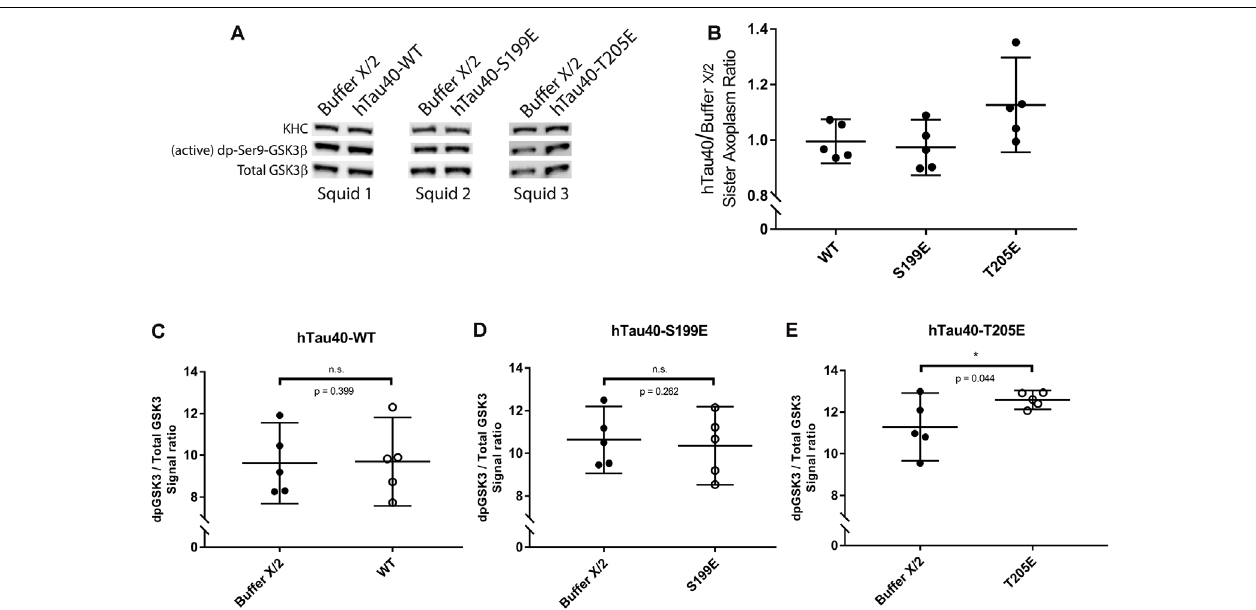
FIGURE 4 | hTau40-T205E activates GSK3 β . (A) Representative images showing immunoblots of lysates from three “sister” axoplasm pairs, each obtained from a single independent squid (squids 1–3; Kang et al., 2016). Each “sister” axoplasm pair was perfused with either Buffer X/2 (control) vs. hTau40-WT monomers, Buffer X/2 vs. hTau40-S199E monomers, or Buffer X/2 vs. hTau40-T205E monomers. After a 50-min incubation, axoplasm lysates were prepared, separated by SDS–PAGE and immunoblots revealed using antibodies recognizing (active) dephosphorylated-ser9-GSK3 β and total GSK3 β . (B) Quantitation of dpGSK3 β immunoblot signal (normalized to total GSK3 β ) for “sister” axoplasm pairs (hTau40/Buffer X/2; n = 5 axoplasm pairs for each hTau40 pseudophosphorylated protein). (C–E) Quantification of active dp-GSK3 β immunoblot signal normalized to total GSK3 β revealed that perfusion of hTau40-T205E monomers led to more active dp-GSK3 β compared to Buffer-X perfused sister axoplasms ( n = 5; p = 0.044; E ). Perfusion of hTau40-WT ( n = 5; p = 0.399; C ) and hTau40-S199E ( n = 5; p = 0.261; D ) did not result in more active dp-GSK3 β .All data are presented as mean ± 95% confidence